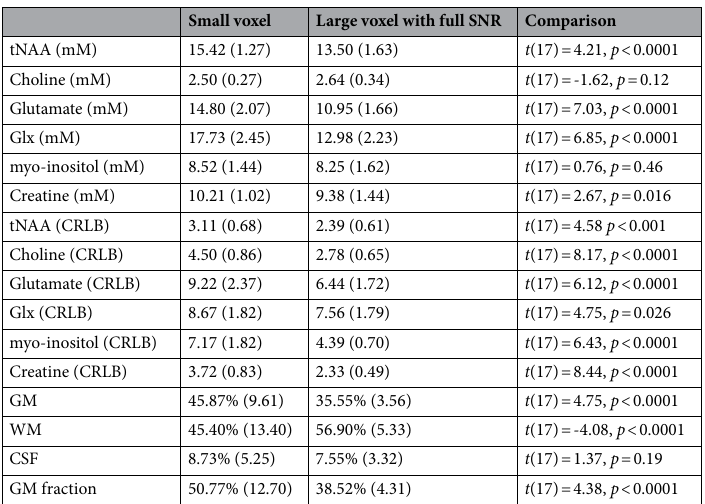
Table 1. Metabolite levels (milli-molal), metabolite Cramer-Rao Lower Bounds (CRLBs) and tissue fraction of the gray matter (GM), white matter (WM), cerebrospinal fluid (CSF) and GM fraction (GM/[GM + WM]) for the small and full SNR large voxel. Values are means with standard deviations in brackets. The results of two- tailed paired t-test comparing differences between